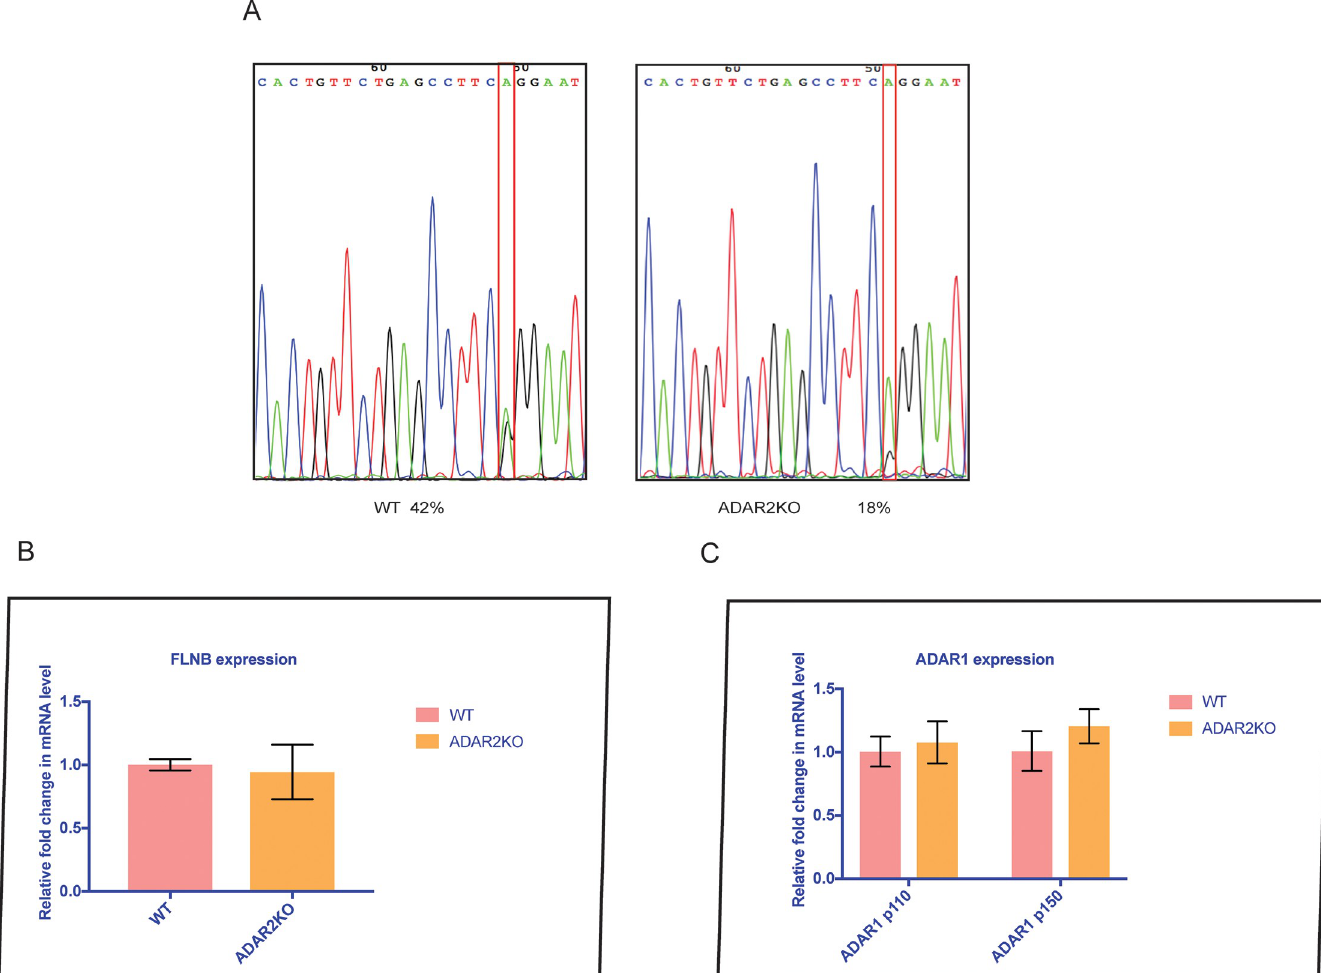
Fig 4. FLNB editing and ADAR1 expression in ADAR2-KO mice. (A) Electropherogram showing a 24% decrease in editing in ADAR2-KO compared to WT mouse tissues. This indicated that FLNB is primarily edited at the Q/R site by ADAR2. (B) Expression analysis of FLNB. The impact of FLNB editing on its expression was evaluated by semi-quantitative real time PCR. The bar graph showed that there was no significant difference in the expression of FLNB in the hearts of ADAR2 -/- mice compared to those of WT mice. This implies that editing of FLNB did not alter its expression. The error bars indicate the mean +/-SD. (C) ADAR1 isoform expression in ADAR2 -/- mouse tissue . The upregulation of ADAR1 in CHD is either because of the absence of ADAR2 or CHD occurrence. Therefore expression of ADAR1 isoforms was determined in the ADAR2KO mouse heart tissues. The bar graph showed no significant difference in the expression of the ADAR1 isoforms (p110 and p150) in the hearts of ADAR2-KO mice compared to those of WT mice. This implies that the upregulation of ADAR1 is due to CHD. The error bars indicate the mean +/-SD.